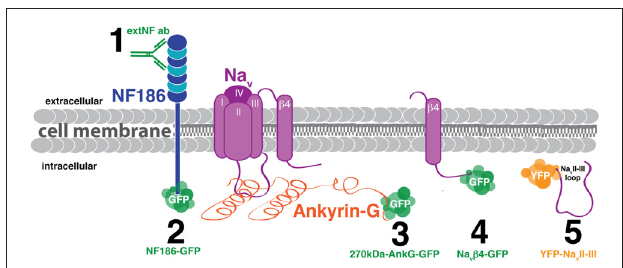
FIGURE 1 | Schematic of candidate methods for live labeling the axon initial segment (AIS) in vitro . (1) Antibody targeted against the neurofascin extracellular domain (extNF ab). (2) Plasmid DNA fusion construct of neurofascin and GFP (NF186-GFP). (3) Plasmid DNA fusion construct of 270kDa-ankyrin-G (AnkG) and GFP (270kDa-AnkG-GFP). (4) Plasmid DNA fusion construct of the sodium channel β 4 subunit and GFP (Na V β